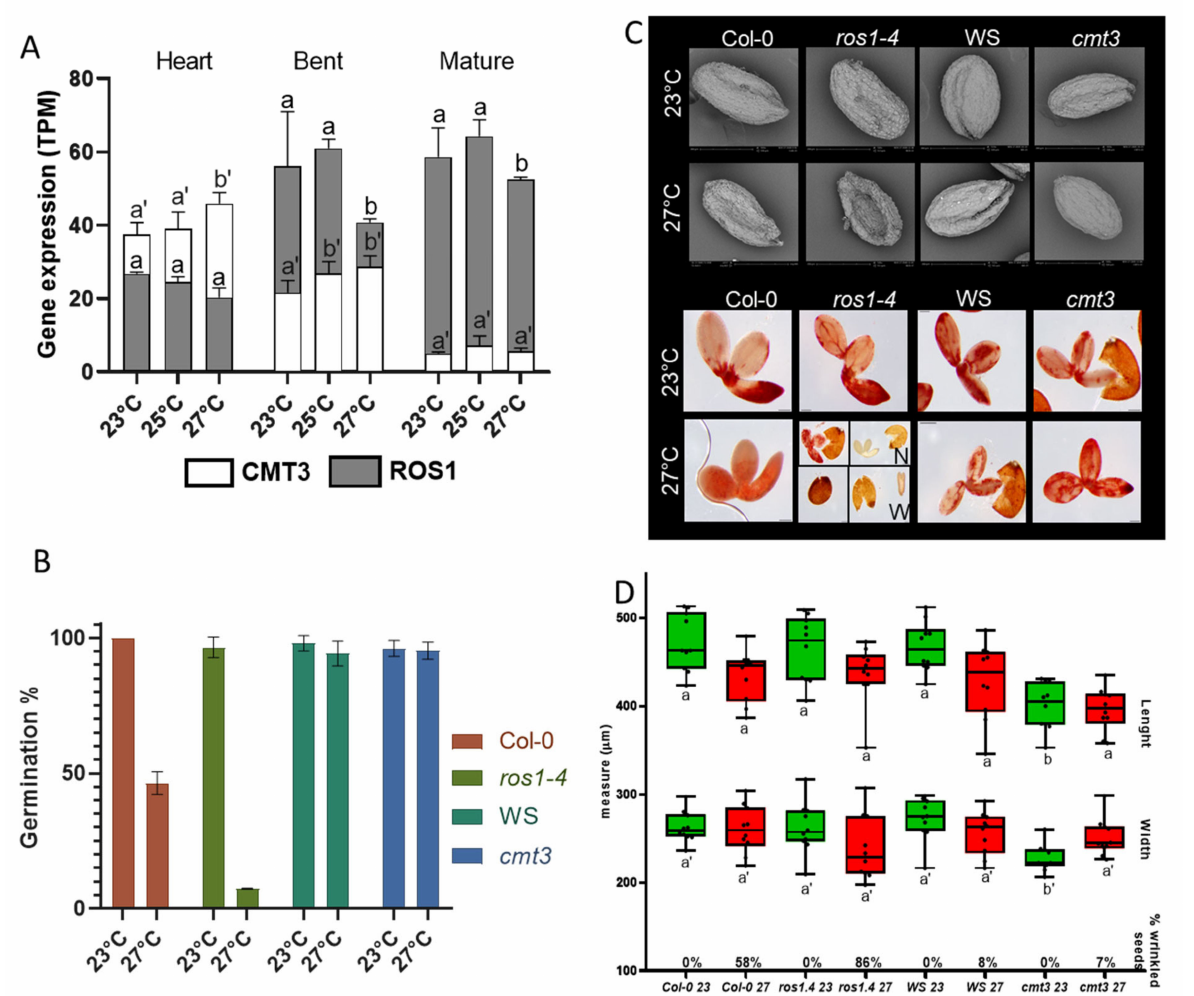
Figure 4. Evaluation of CMT3 and ROS1 expression and physiology of cmt3 and ros1-4 mutants. ( A ) Gene expression in TPM of CMT3 and ROS1 at heart, bent, and mature stages of embryo development during control temperature (23 ◦ C), MS (25 ◦ C) and SS (27 ◦ C). CMT3 is represented by white bars while ROS1 is represented by grey bars. Standard deviation is shown. Two-way ANOVA comparing differences in gene expression at 23 ◦ C, 25 ◦ C, and 27 ◦ C for each genotype at the same stage. Letters represent statistically significant differences with a p -value < 0.001. Letters a or b used for ROS1 and letters a’ or b’ used for CMT3 . ( B ) Seed germination for wild-type (Col-0 or WS) and mutant ( ros1-4 or cmt3 ) genotypes at 23 ◦ C (green) and 27 ◦ C (red) average temperature. ( C ) Panels show embryos and seed coats from wild-types (Col-0 or WS) and mutant ( ros1-4 or cmt3 ) genotypes at 23 ◦ C and 27 ◦ C average temperature. The upper panel is composed of electronic microscopy photos for phenotype observations and the lower panel shows embryo survival evaluation with TTZ. ros1-4 at 27 ◦ C was divided into normal-shaped seeds (N) or wrinkled-shaped seeds (W). ( D ) Seed measurements of length and width in micrometers. Boxes and whiskers showing minimum and maximum with median line from all observations. Green bars represent temperature at 23 ◦ C and red bars represent the temperature at 27 ◦ C (SS). Two-way ANOVA comparing difference size between wild-types (Col-0 or WS) and mutants ( ros1-4 or cmt3 ), respectively, at 23 ◦ C wild-type against 23 ◦ C mutant, and 27 ◦ C wild-type against 27 ◦ C mutant, therefore green against green and red against red. Letters represent statistically significant differences with a p -value < 0.001. Letters a or b used for length measures and letters a’ or b’ used for width measures. Percentage of wrinkle-shaped seeds for each genotype at 23 ◦ C and 27 ◦ C is shown at the base of the x